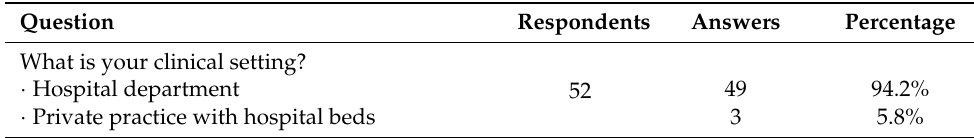
Table 1. Answers of the survey about laparoscopic inguinal hernia